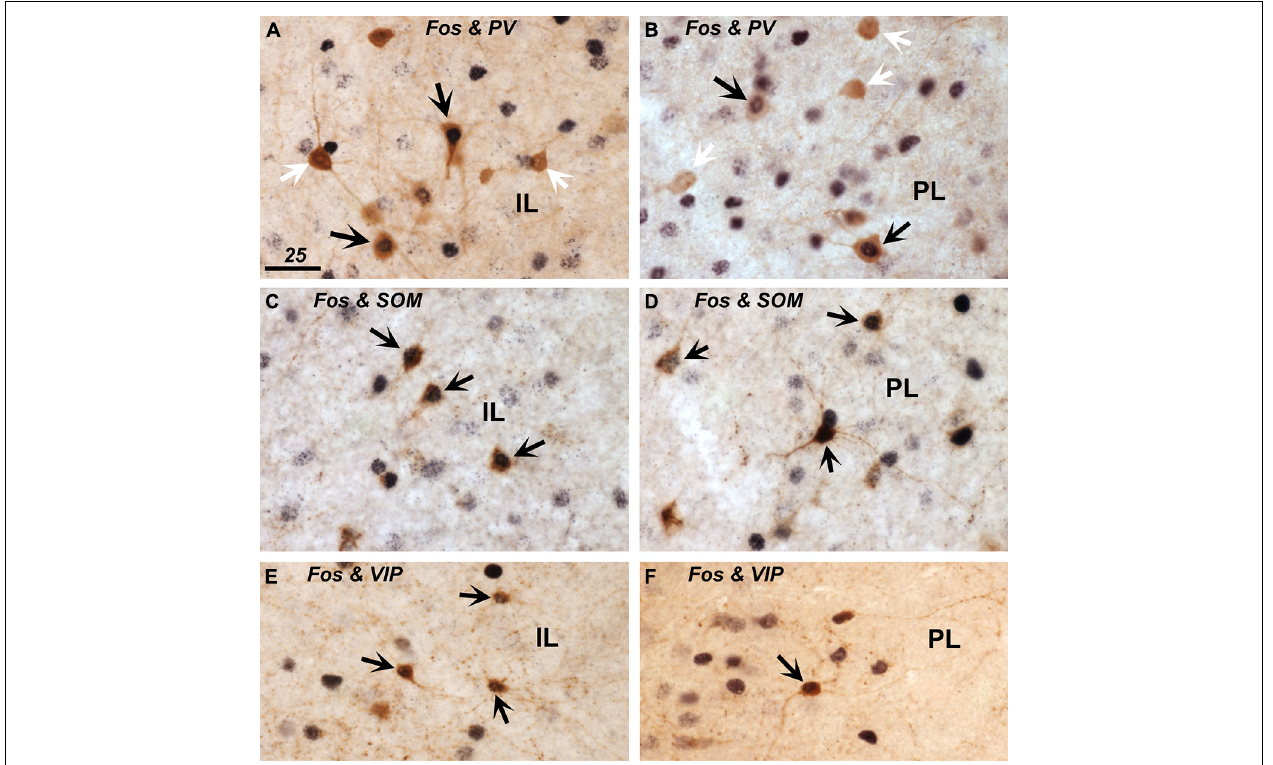
FIGURE 4 | Expression of Fos protein in inhibitory interneurons immunostained for parvalbumin (PV; inA,B), somatostatin (SOM; in C,D), and vasoactive intestinal polypeptide (VIP; in E,F) within the infralimbic (IL; inA,C,E) and prelimbic cortex (PL; in B,D,F). Double-labeled